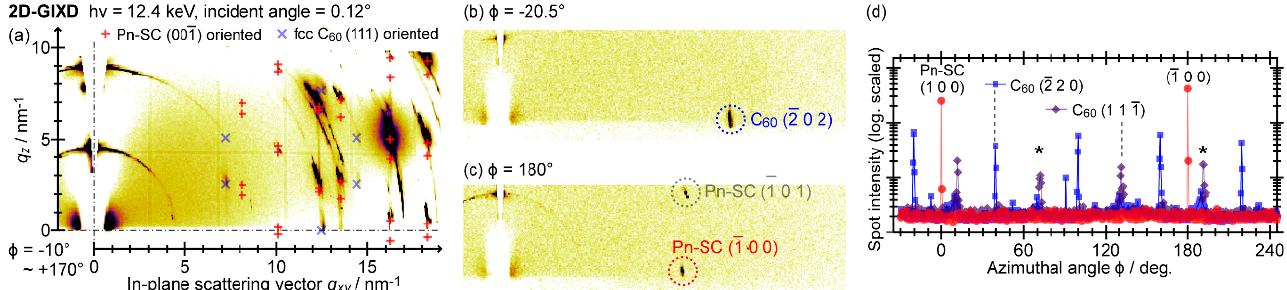
Figure 4. ( a ) 2D-GIXD image of a PnSC sample covered with 20 nm-thick C 60 obtained by integration of the sample azimuthal angle over 180 ◦ . ( b , c ) 2D-GIXD images taken at specific sample azimuthal angles. Single marks were ascribed tosignals from misoriented crystallites. ( d ) 2D-GIXD intensities of the spots corresponding to the denoted diffractions plotted as a function of the sample azimuthal angle. Cited from [37].